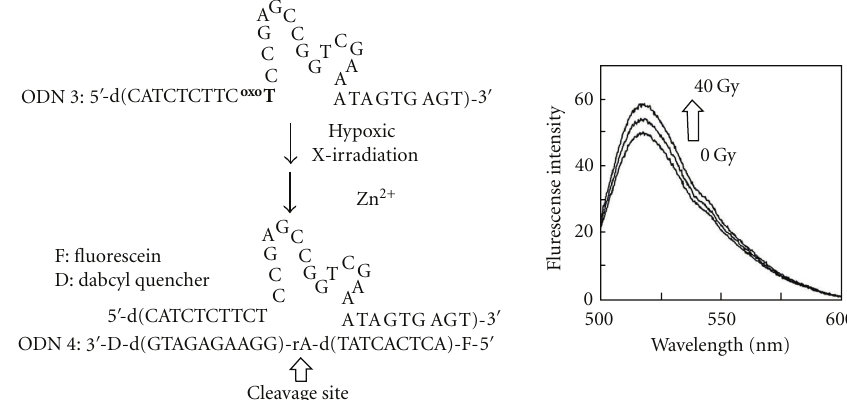
Figure 4: Design of caged DNAzyme activated by X-irradiation. (a) Schematic illustration of radiolytic activation of DNAzyme possessing 2-oxoalkyl group. (b) Fluorescence spectra of ODN 4 (500nM) after addition of Zn 2+ ion (100 μ M) and X-irradiated (0, 20 and 40 Gy) ODN 3 (500nM) under hypoxic conditions.